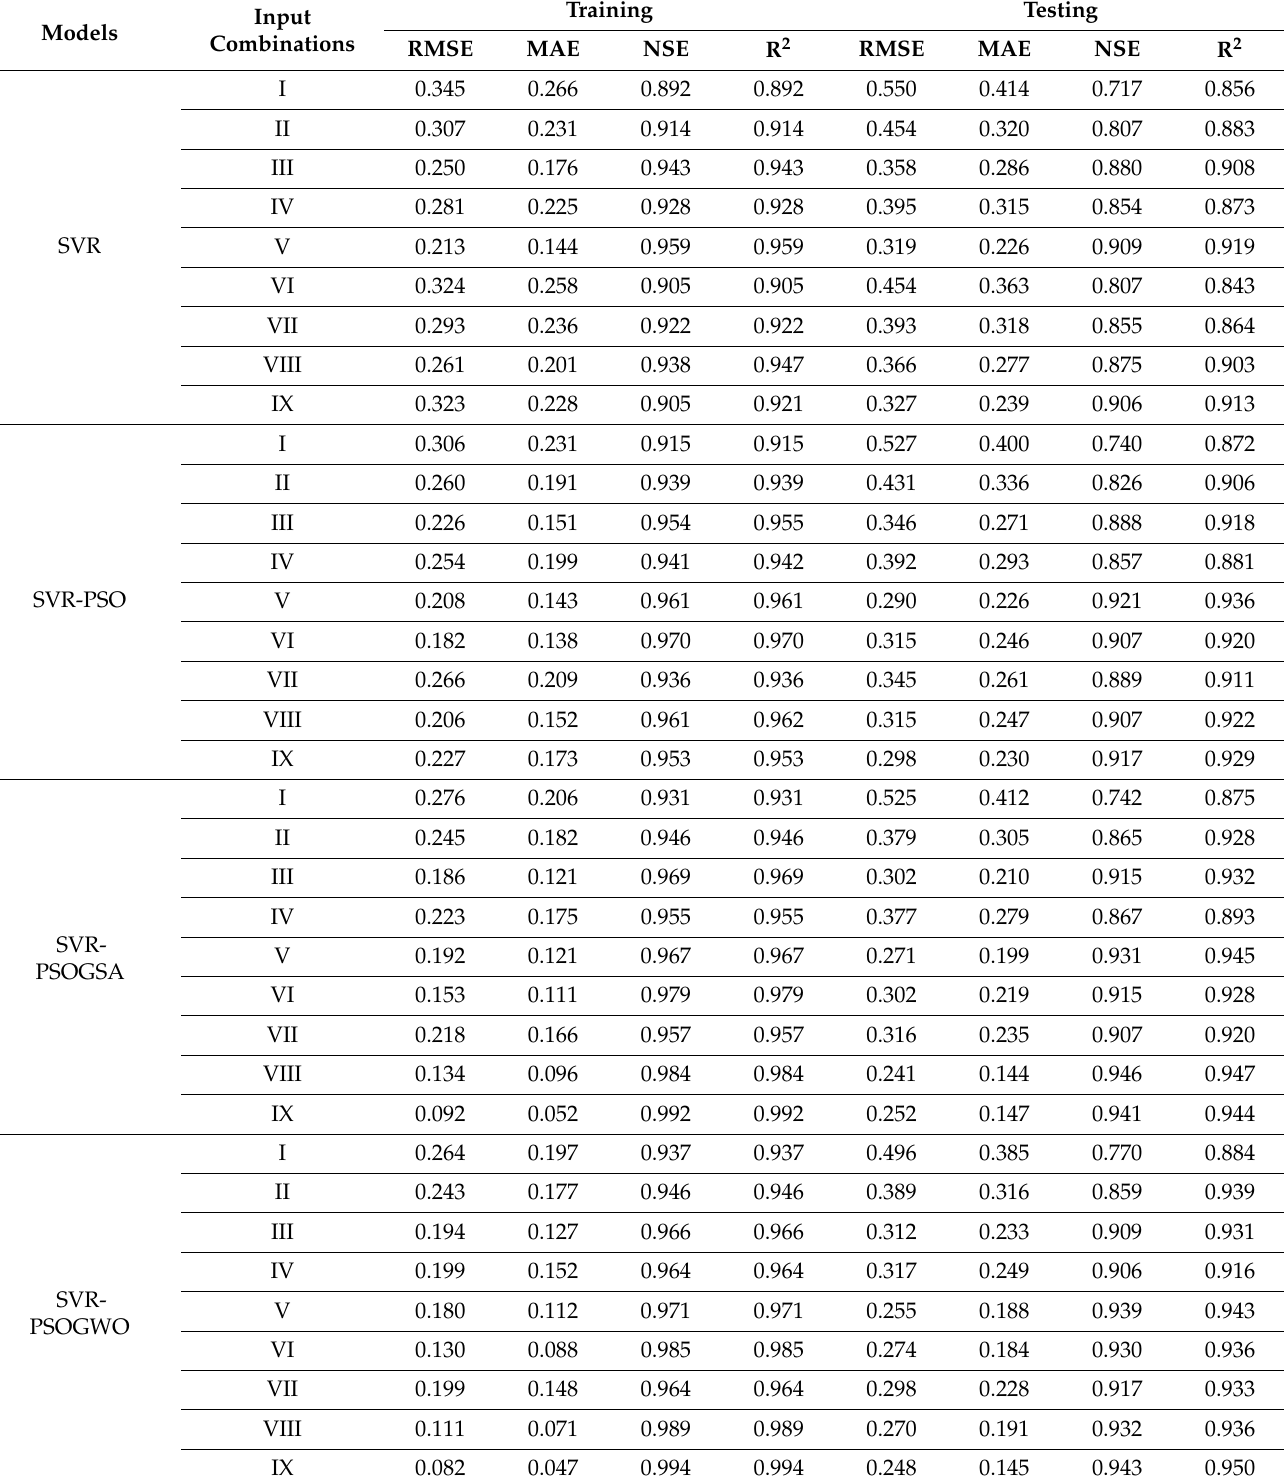
Table 5. The results of Station 2 (Rajshahi) using SVR-based